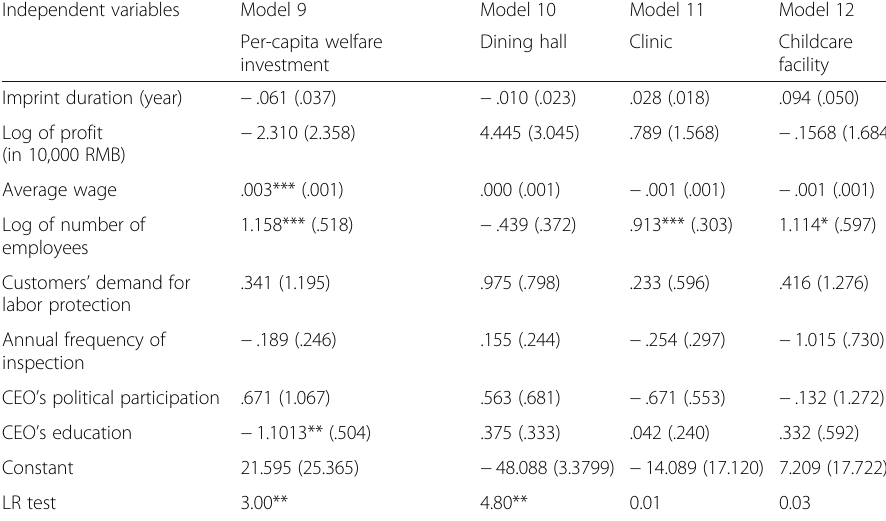
Table 4 Influence of imprint duration on organizational welfare practices Independent variables